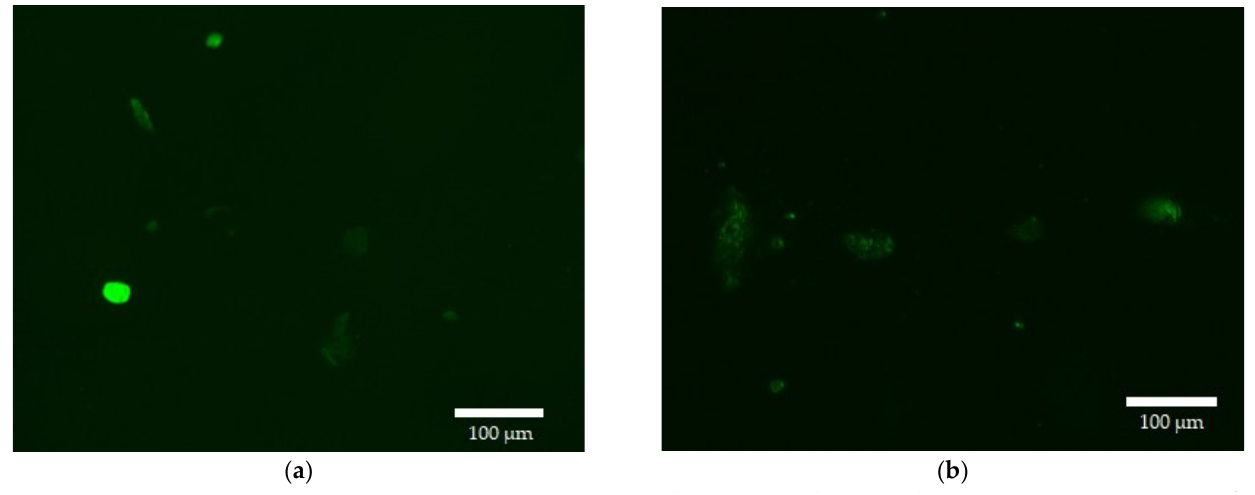
Figure 12. Fluorescence images of HEK293T after 2 h of incubation with Dox 10 µg/mL: ( a ) free; ( b ) in micelles of Chit5-MUA-20 with EG. Highlighted in green for ease of perception and so as not to confuse healthy cells with cancerous ones. The scale segment is 100 µm. λ exci = 500–560 nm. Table 4. A549- and HEK293T-associated fluorescence (conventional units) depending on the composition of the Dox-containing formulation (10 µg/mL). Determined by fluorescent image analysis and fluorescence quantification of Dox uptake by the absorption of solution over cells. PBS (0.01M, pH 7.4). T = 37 ° С .